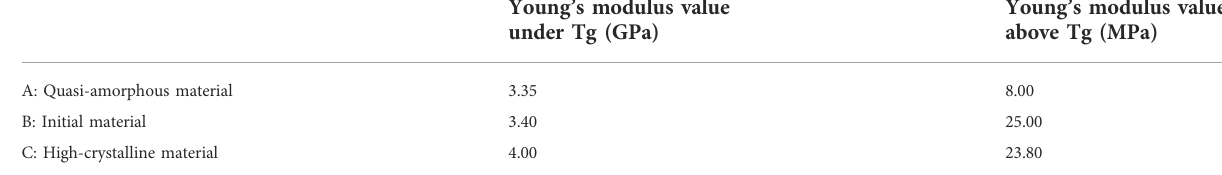
Young ’ s modulus value above Tg (MPa)